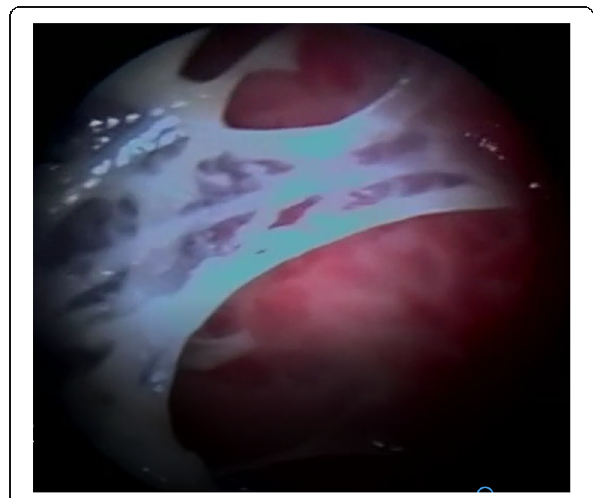
Fig. 2 Encysted empyema with adhesions between visceral and parietal pleura